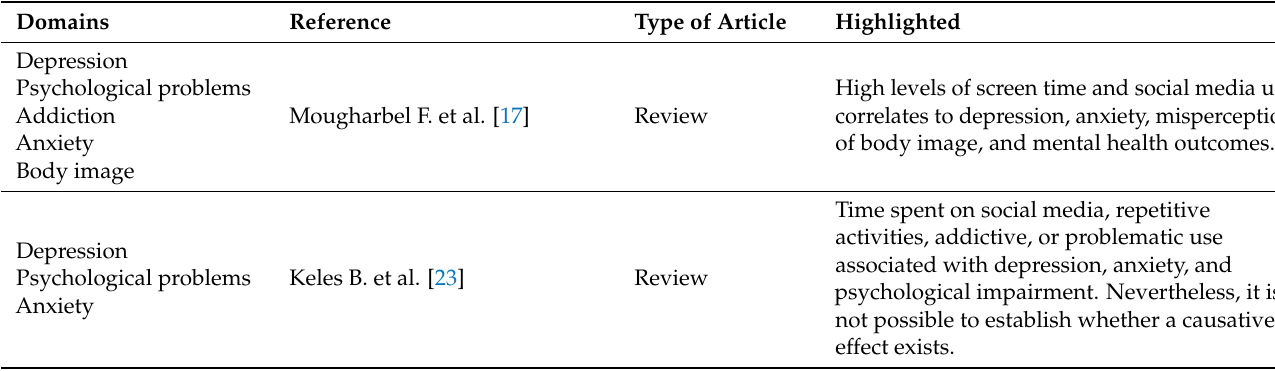
Table 5. Social media and psychological